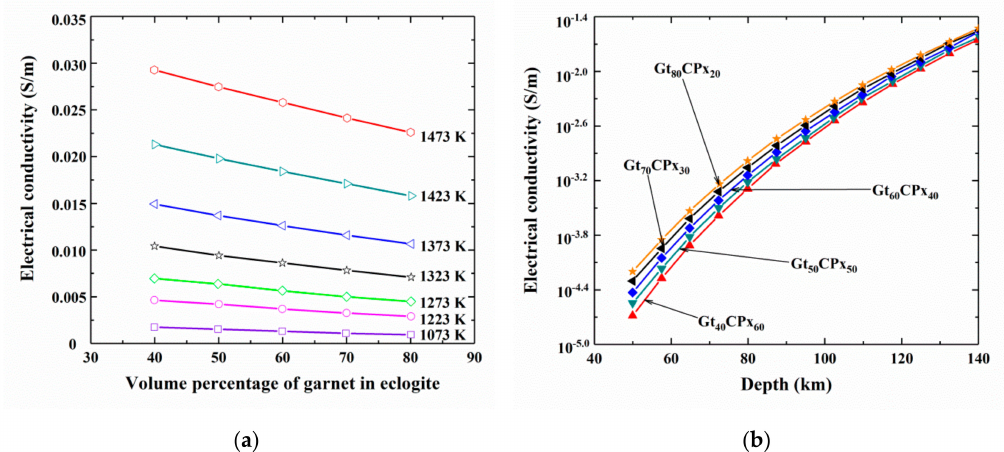
Figure 10. ( a ) The calculated electrical conductivity of eclogite as a function of the volume percentage of garnet, based on the obtained conductivity results of pyrope-rich garnet at conditions of 2.0 GPa, 1073–1473 K and the Ni–NiO oxygen bu ff er (modified from Dai et al. [39]). ( b ) The EC of eclogite at di ff erent volume percentages of the constituent minerals, i.e., garnet (Gt) and clinopyroxene (CPx) at depths of 40–140 km, at conditions of 2.0 GPa, 873–1473 K and the Ni–NiO solid oxygen bu ff er (Reproduced with permission from Dai et al., Contrib. Miner. Petrol.; published by Springer Nature, 2012